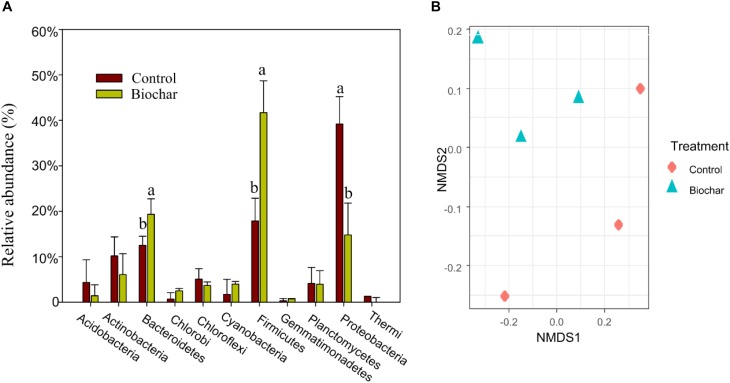
Effect of the biochar amendment on soil bacterial communities in the rhizosphere. (A) Taxonomic composition. Significant differences between treatments were tested by one-way ANOVA with Fisher’s LSD test, different letters indicate that significance at P < 0.05 level. (B) Ordination of Bray-Curtis dissimilarities (k = 4; stress = 0.04).